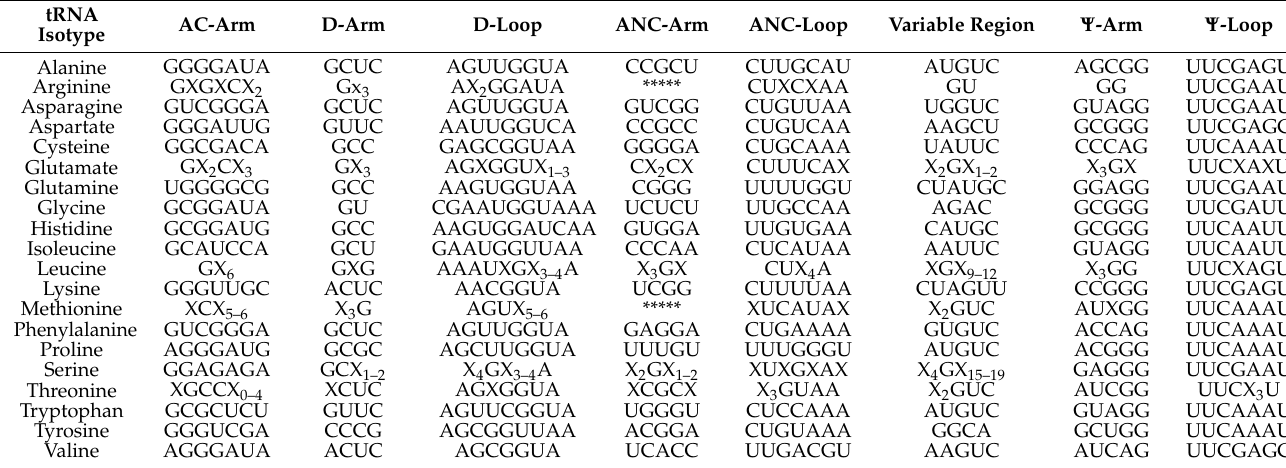
Table 3. Sequence alignment and the presence of isotype-specific conserved nucleotide consensus sequences in the cotton chloroplast tRNAs.